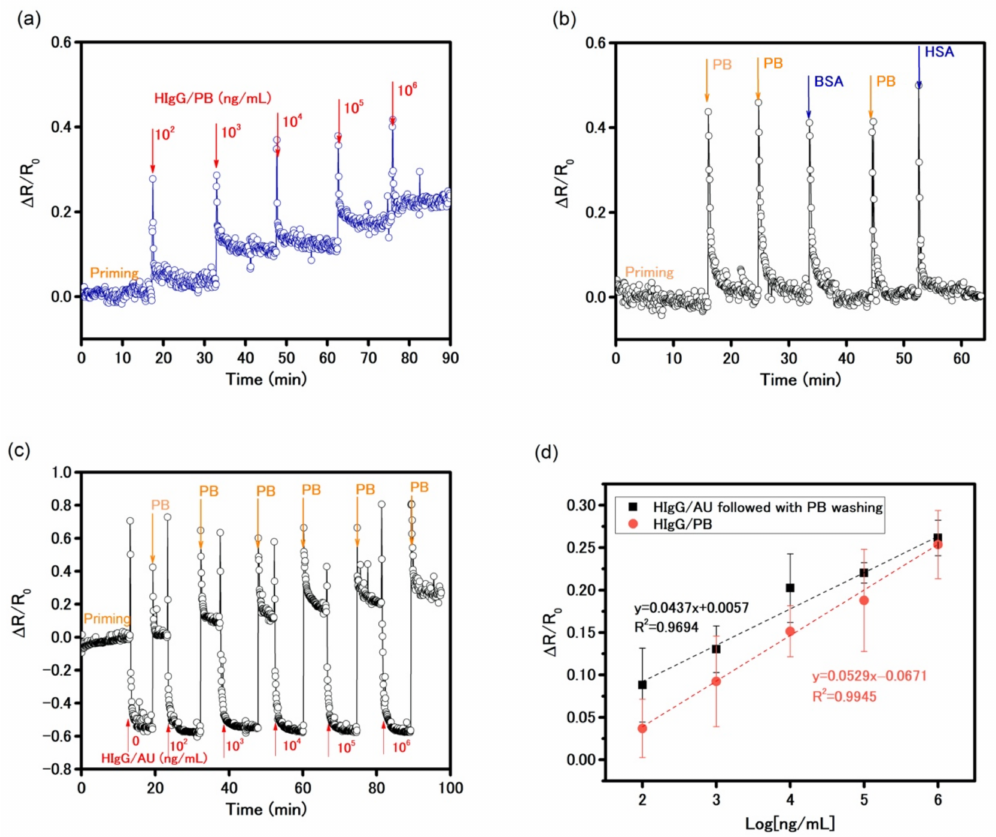
Figure 6. ( a ) Real-time monitoring of the changes in resistance for HIgG sensing and the priming process with 10 mM PB (V ds = 1 V and V gate = 0 V). ( b ) Control sensing experiment with PB solution and high concentration nonspecific antigens of BSA (10 5 ng/mL) and HSA (10 5 ng/mL). ( c ) Real-time monitoring of the changes in resistance for HIgG sensing in AU with 10 mM PB wash (V ds = 1 V and V gate = 0 V). ( d ) Calibration curves of Al 2 O 3 passivated MoS 2 -based sensor for HIgG detections in PB and AU solutions. Data points are average of 3 measurements and error bars represent ± 1